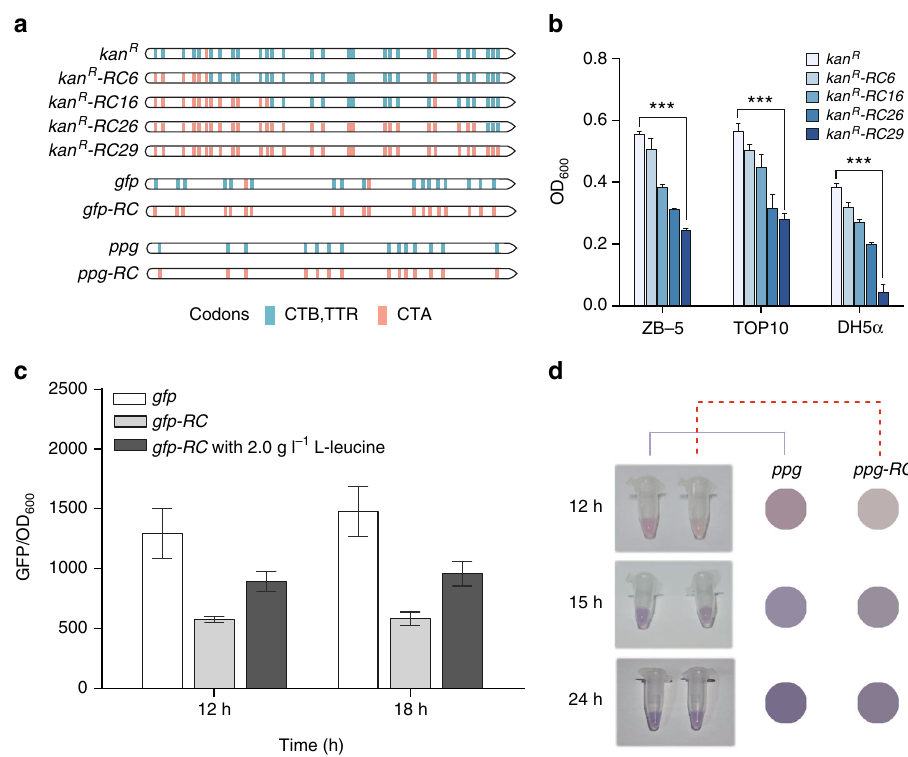
Fig. 2 Effects of the frequency of leucine rare codon CTA on protein expressions. a Different numbers of the leucine codons on the wild-type kan R were replaced by the rare one CTA, generating kan R -RC6 , kan R -RC16 , kan R -RC26 , and kan R -RC29 ; the leucine codons on the wild-type gfp and ppg were also replaced by the rare alternative, generating gfp-RC and ppg-RC , respectively. b In fl uences of rare codon frequency on cell OD 600 for E. coli strains harboring the rare codon-rich kan R (*** P < 0.001 as determined by two-tailed t test). c Effects of the incorporation of leucine rare codon CTA and L -leucine feeding on GFP expression. d Effects of the incorporation of leucine rare codon CTA on PPG expression as indicated by the differences in color development. Values and error bars represent the mean and the s.d. ( n =